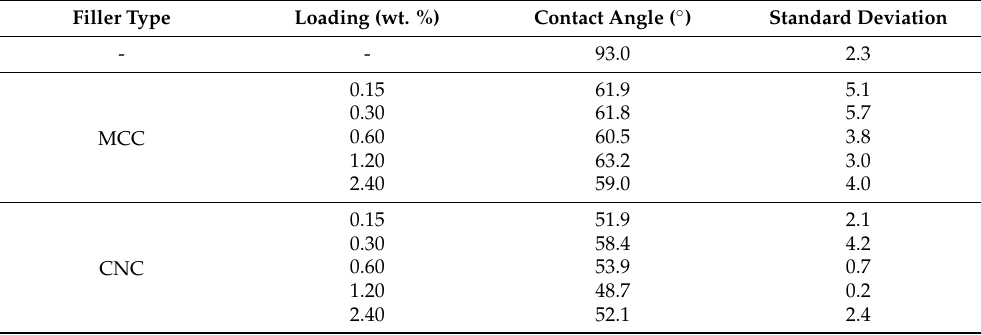
Table 8. Contact angle values with water for PEGDA : AESO 20:80 and its composites containing MCCs or CNCs. Statistical analyses were performed using Pearson’s correlation for MCC and CNC with p < 0.05.